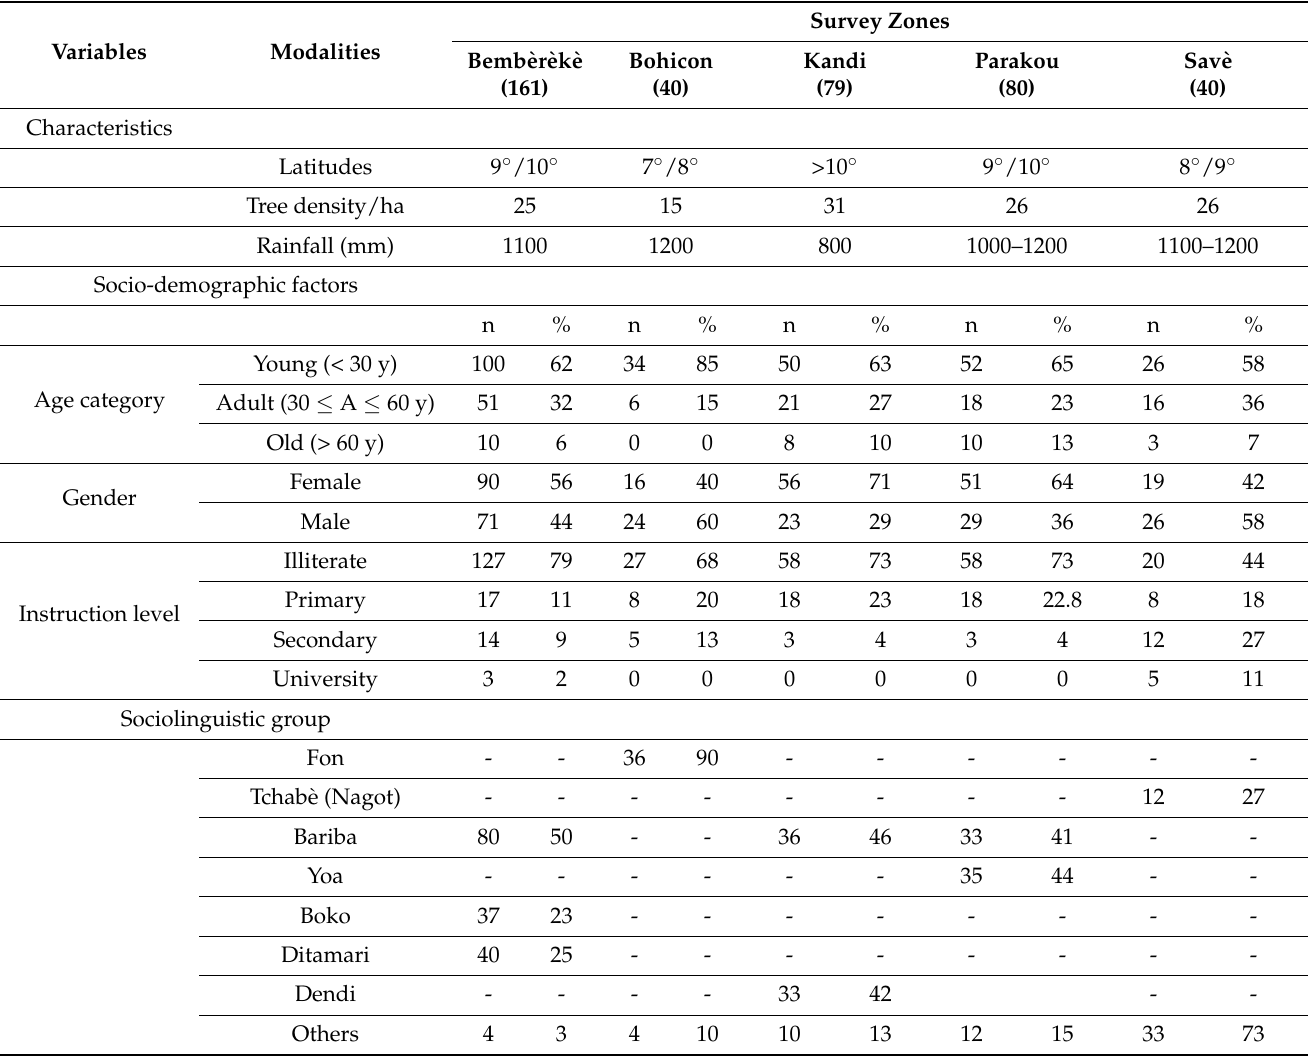
Table 4. Socio-demographic and sociolinguistic group characteristics of the survey population. n— number of respondents. Numbers in parentheses represent total number of respondents surveyed in each